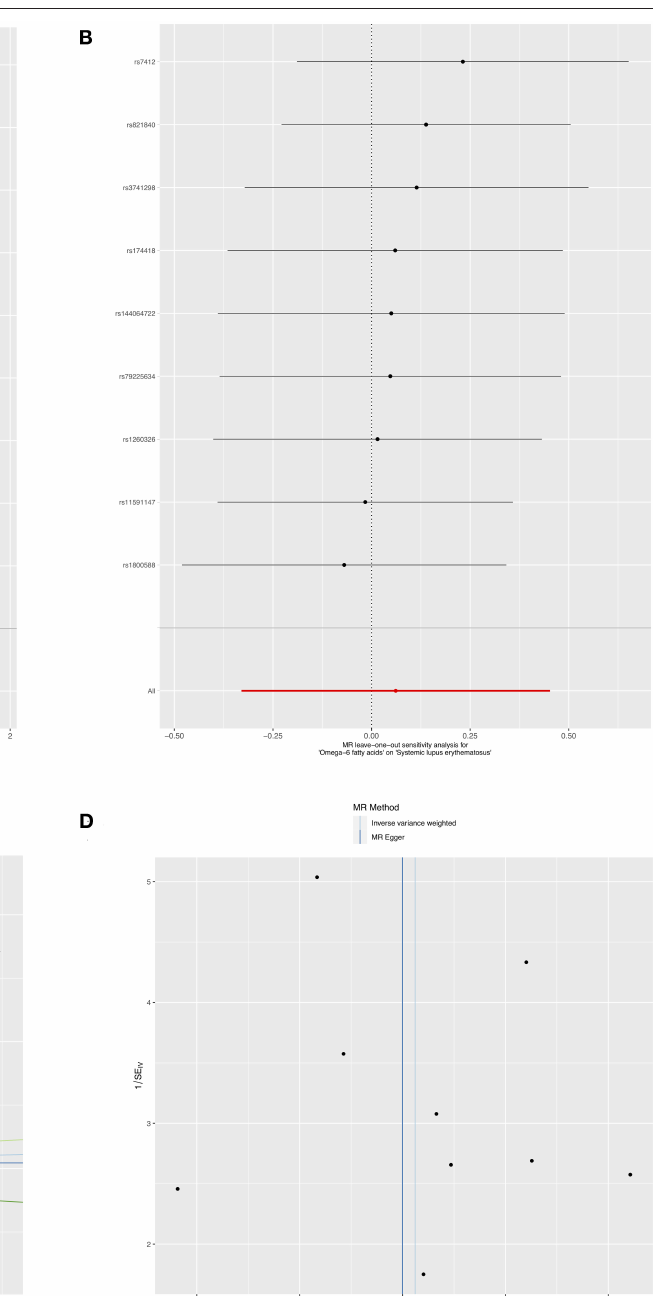
the sample size, and k is the number of included SNPs. When F > 10, the correlation is considered strong enough to avoid the deviation caused by weak IVs (25); (2) IVs are independent of confounding factors; (3) IVs can only influence the outcome through their effect on exposure, nor are causal pathway to outcome other than exposure. MR-Egger regression was